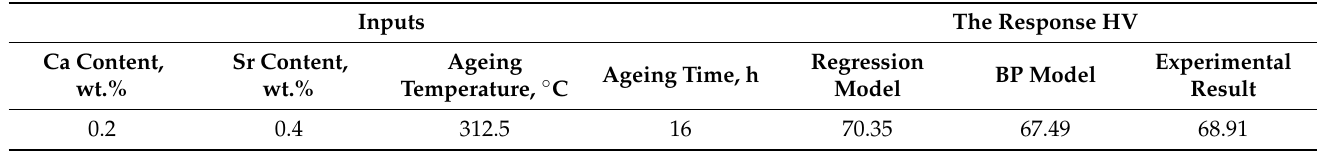
Table 5. The comparison between the developed models and experimental results. Inputs The Response